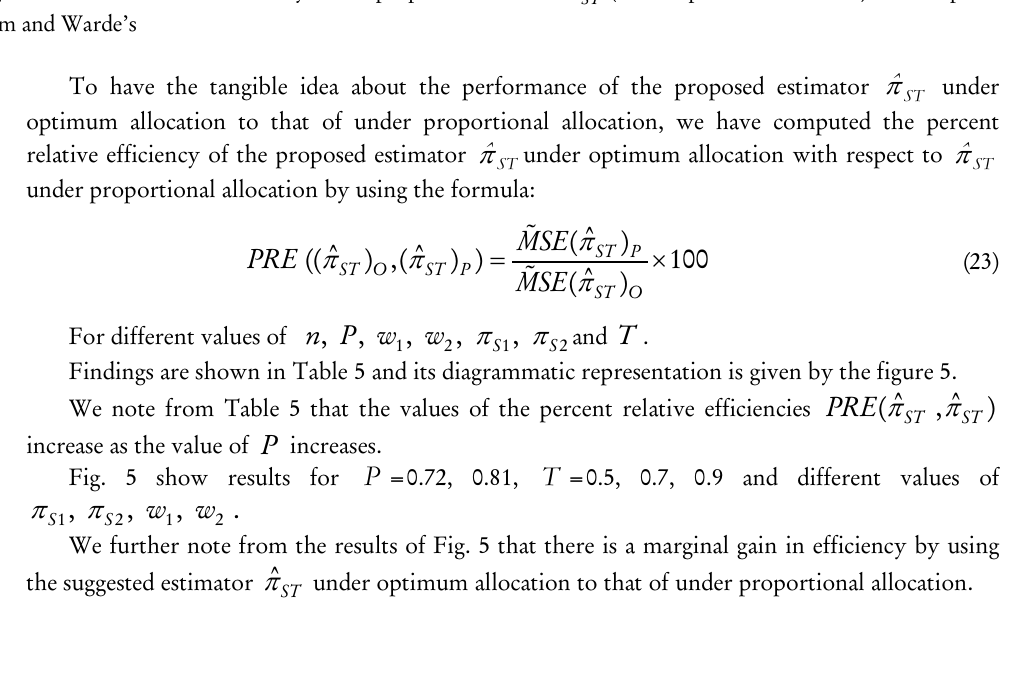
ˆ π (under optimum allocation) with respect to th ST